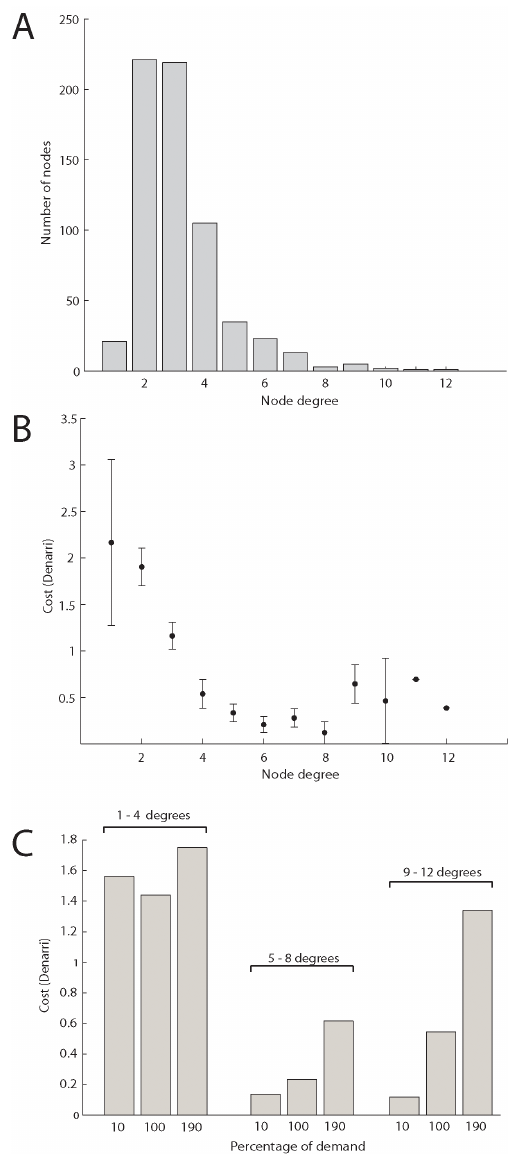
Figure 5. Cost to import VW in relation to node degree. (a) The node degree distribution of the virtual water redistribution network. (b) Lower-degree nodes generally have higher costs to import VW compared with high-degree nodes. For the highest-degree nodes, the cost to import is higher than nodes with an intermediate number of links as many of the highly connected nodes in our network are also ports or urban centres with high demand. Therefore nearby nodes are often depleted leading to the need to import from further away with an associated increase in cost. (c) For nodes with 1–4 links, import costs remain high irrespective of the level of demand. How- ever, for nodes with 5–8 links and 9–12 links, costs increase under increasing demand. 100% demand represents the standard model simulations presented elsewhere in the